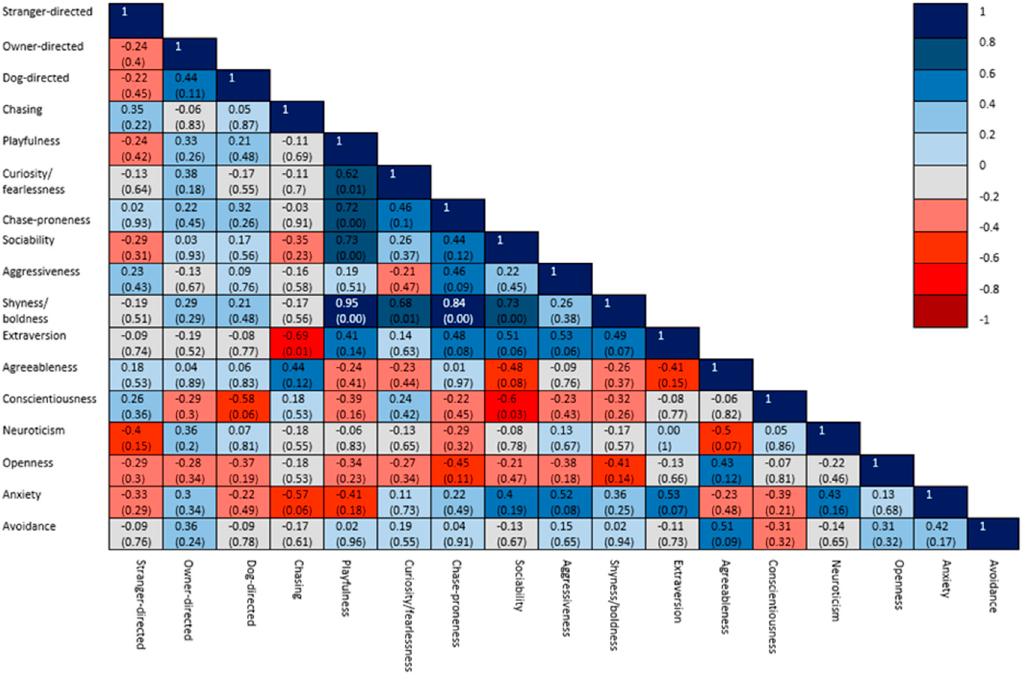
Figure 3. Correlation matrix of the coefficients of the variables in the group of non-aggressive dogs, with significance levels in brackets.